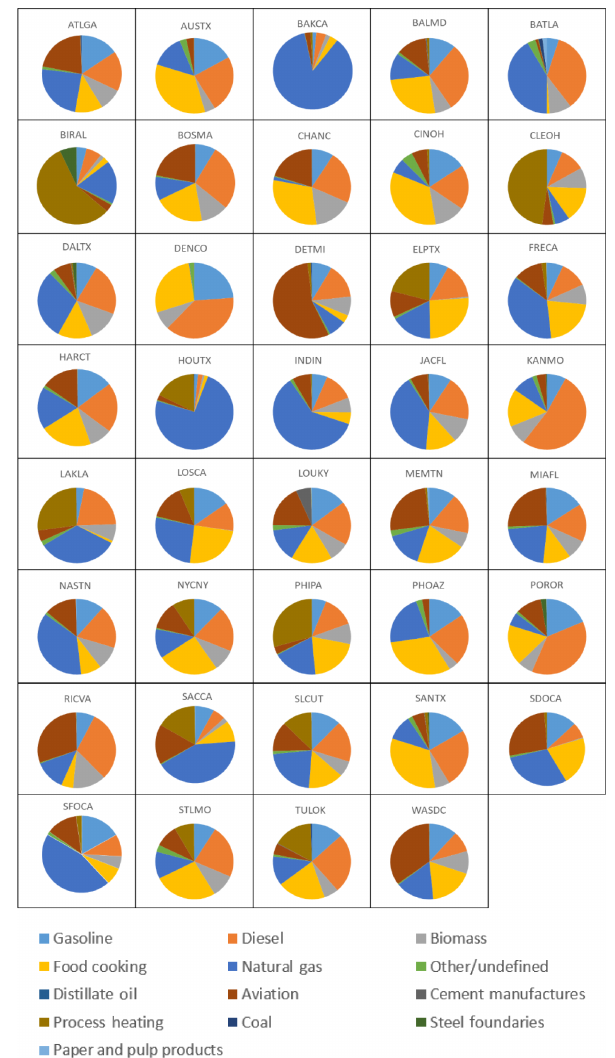
Figure 7. PM 0 . 1 source contribution for 39 cities across the conti- nental